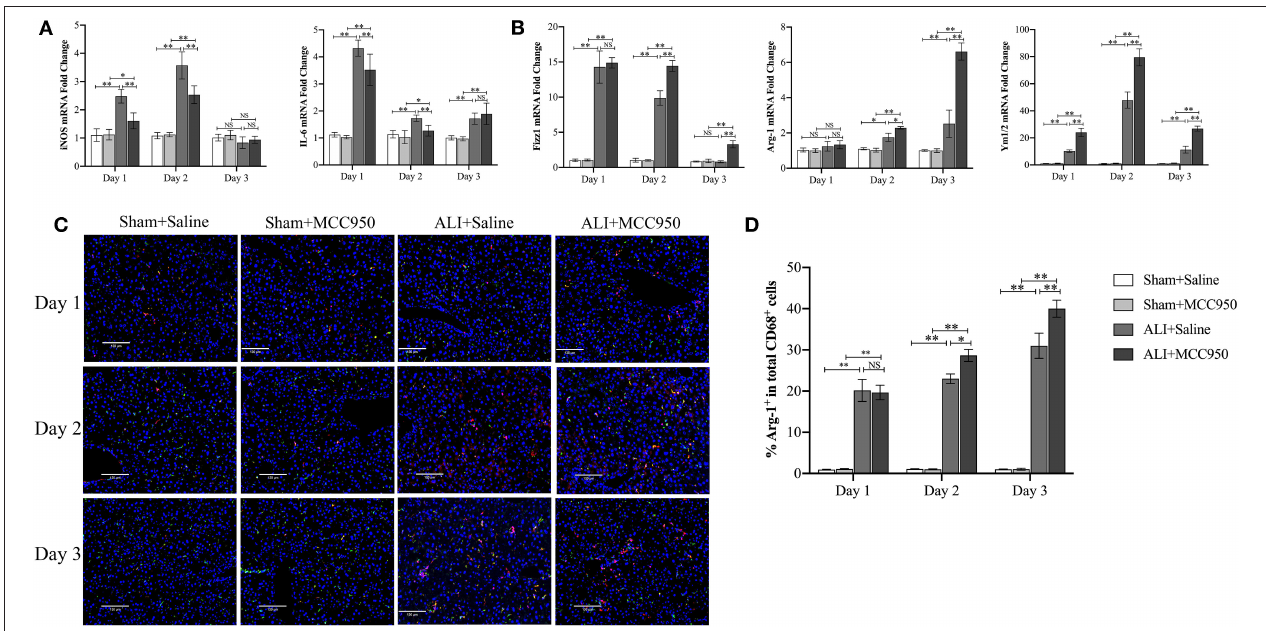
FIGURE 4 | MCC950 prevents acute liver injury through polarizing macrophage into M2 phenotype. (A) Real-time PCR (RT-PCR) analysis of M1-related genes such as inducible nitric oxide synthase (iNOS) and interleukin-6 (IL-6) messenger RNA (mRNA) levels in liver tissues from CCl 4 -treated mice pretreated with vehicle or MCC950 on days 1, 2, and 3. (B) RT-PCR analysis of M2-related genes such as Fizz1, Arg-1, and Ym1/2 mRNA levels in liver tissues from CCl 4 -treated mice pretreated with vehicle or MCC950 on days 1, 2, and 3. (C) Representative images of double-immune fluorescence staining with CD68 and Arg-1 in frozen liver section from different mice. Nuclei were counterstained with 4 ′ -6-diamidino-2-phenylindole dihydrochloride (DAPI). (D) Quantitation of liver tissue M2 macrophages as indicated by the percentage of CD68 + Arg-1 + (%M2) among total CD68 + cells ( n = 8–9 field/group). Data are presented as mean ± SEM. NS: No significance. * p < 0.05, ** p < 0.01. Intergroup differences are determined by the Student’s t -test.